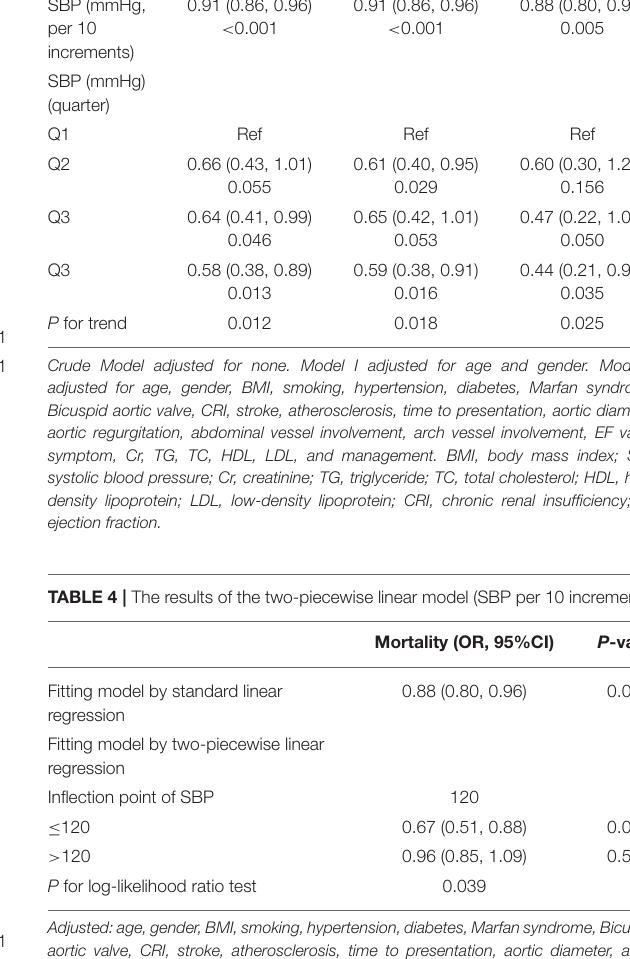
TABLE 3 | Relationship between systolic blood pressure and in-hospital mortality in different models. Exposure Crude Model (OR, Model I (OR, Model II (OR, 95%CI, P ) 95%CI, P ) 95%CI, P )